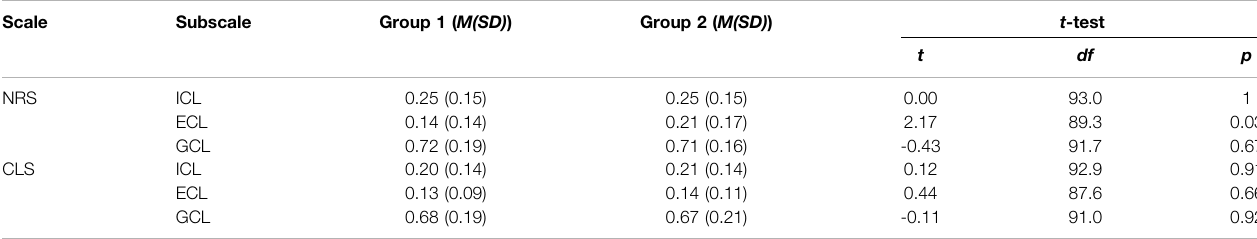
TABLE 4 | Group-speci fi c results for both adapted